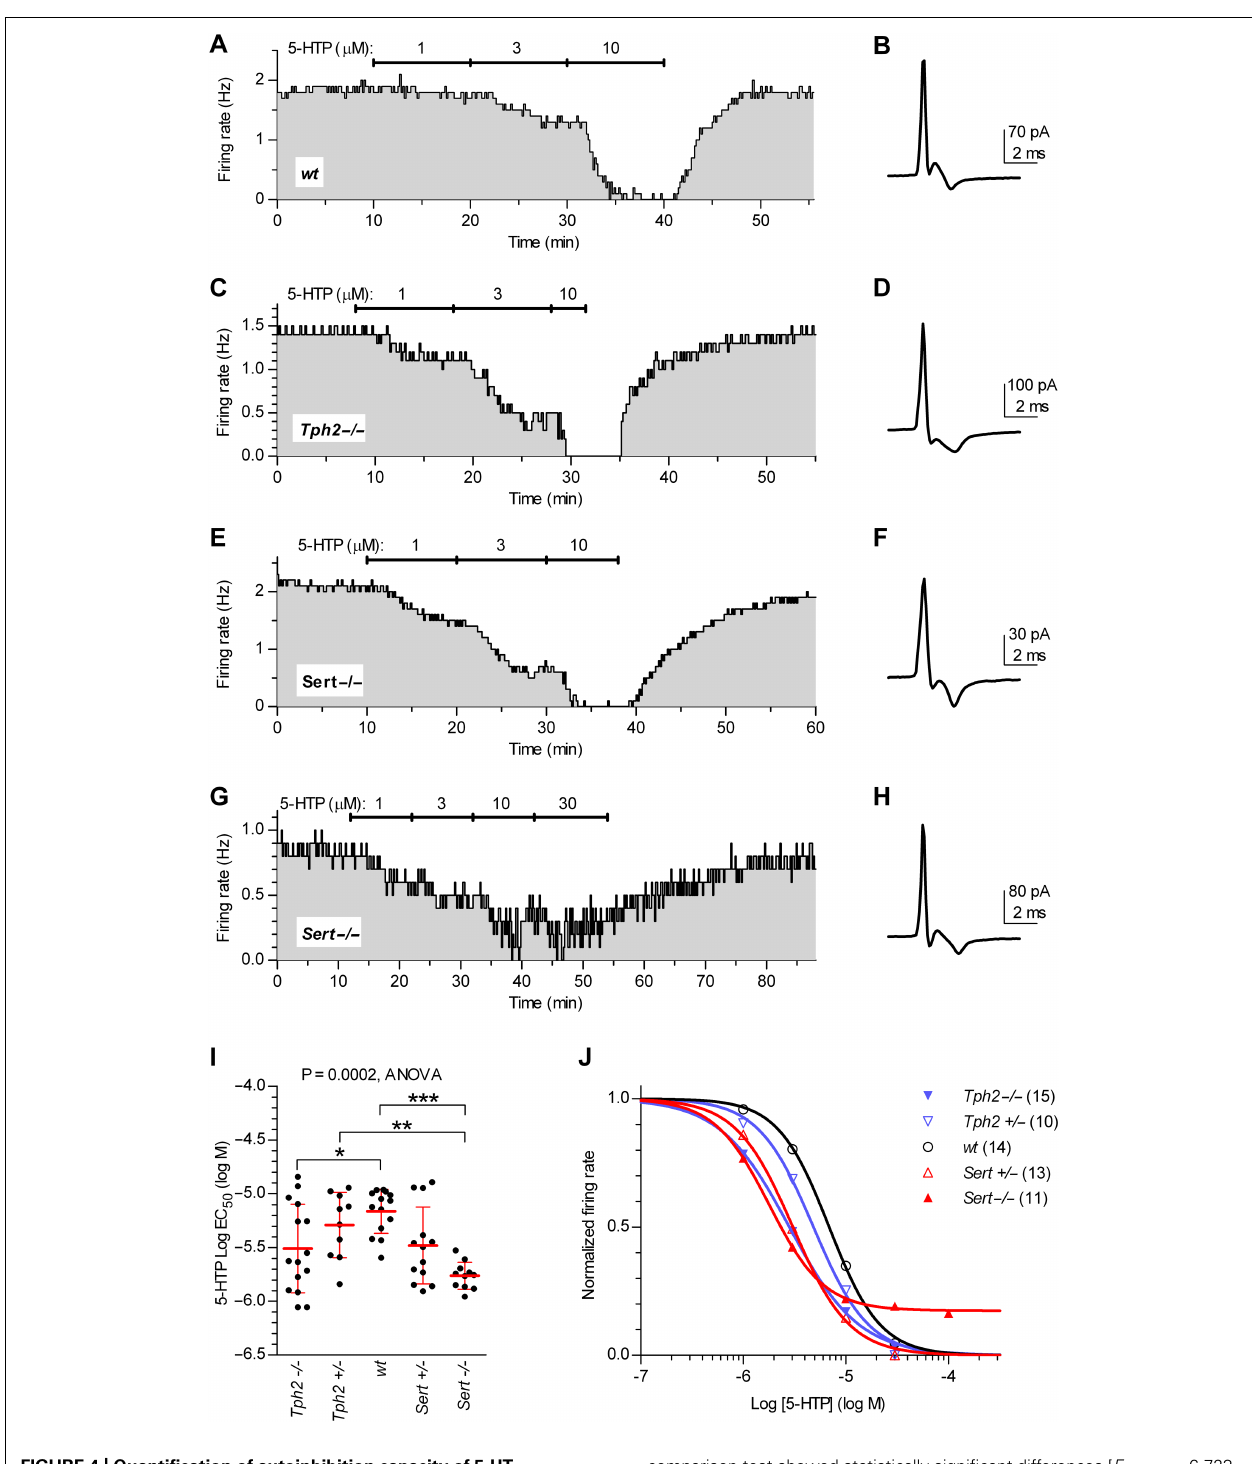
comparison test showed statistically significant differences [ F ( 4,58 ) = 6.723, p = 0.0002] Asterisks indicate level of statistical significance between the indicated genotypes: *** p < 0.001, ** p < 0.01, * p < 0.05. (J) Average concentration–response curves obtained from all the experiments. Each data point corresponds to the mean from several neurons (numbers shown in parentheses). For the sake of clarity, error bars are omitted. Data are normalized on average baseline firing rates recorded before 5-HTP